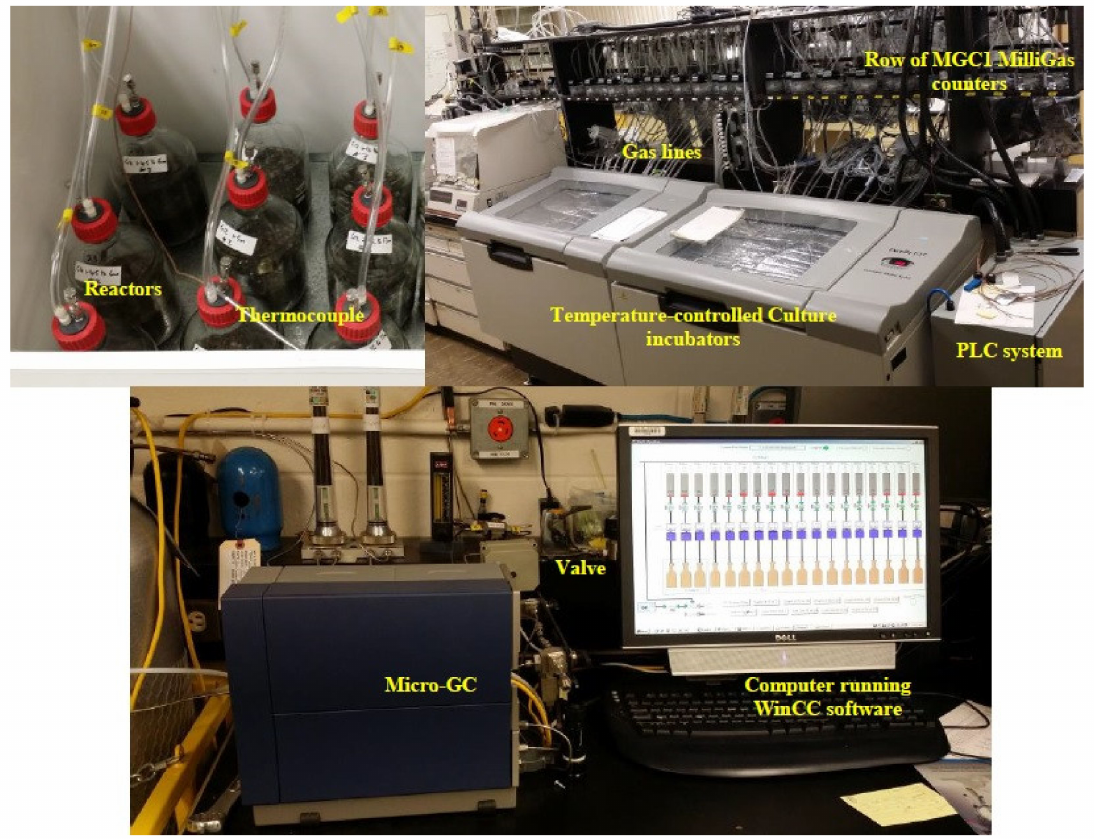
Figure 3. InnoTech Alberta’s BMP batch culture automated sampling system including the programmable logic controller (PLC). The biogas produced was measured using a Milligas counter and gas composition analyzed by a CP4900